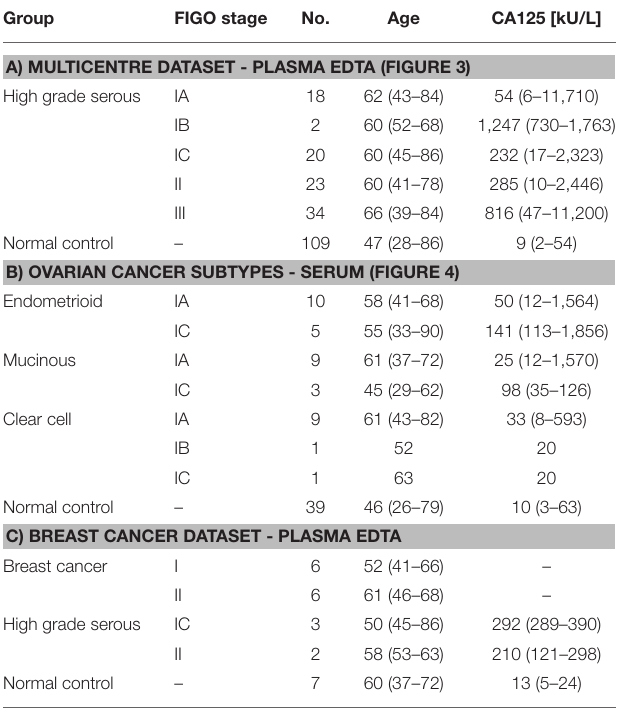
TABLE 1 | Descriptive statistics of patient samples used for the JUP ELISAs. FIGO stage No.